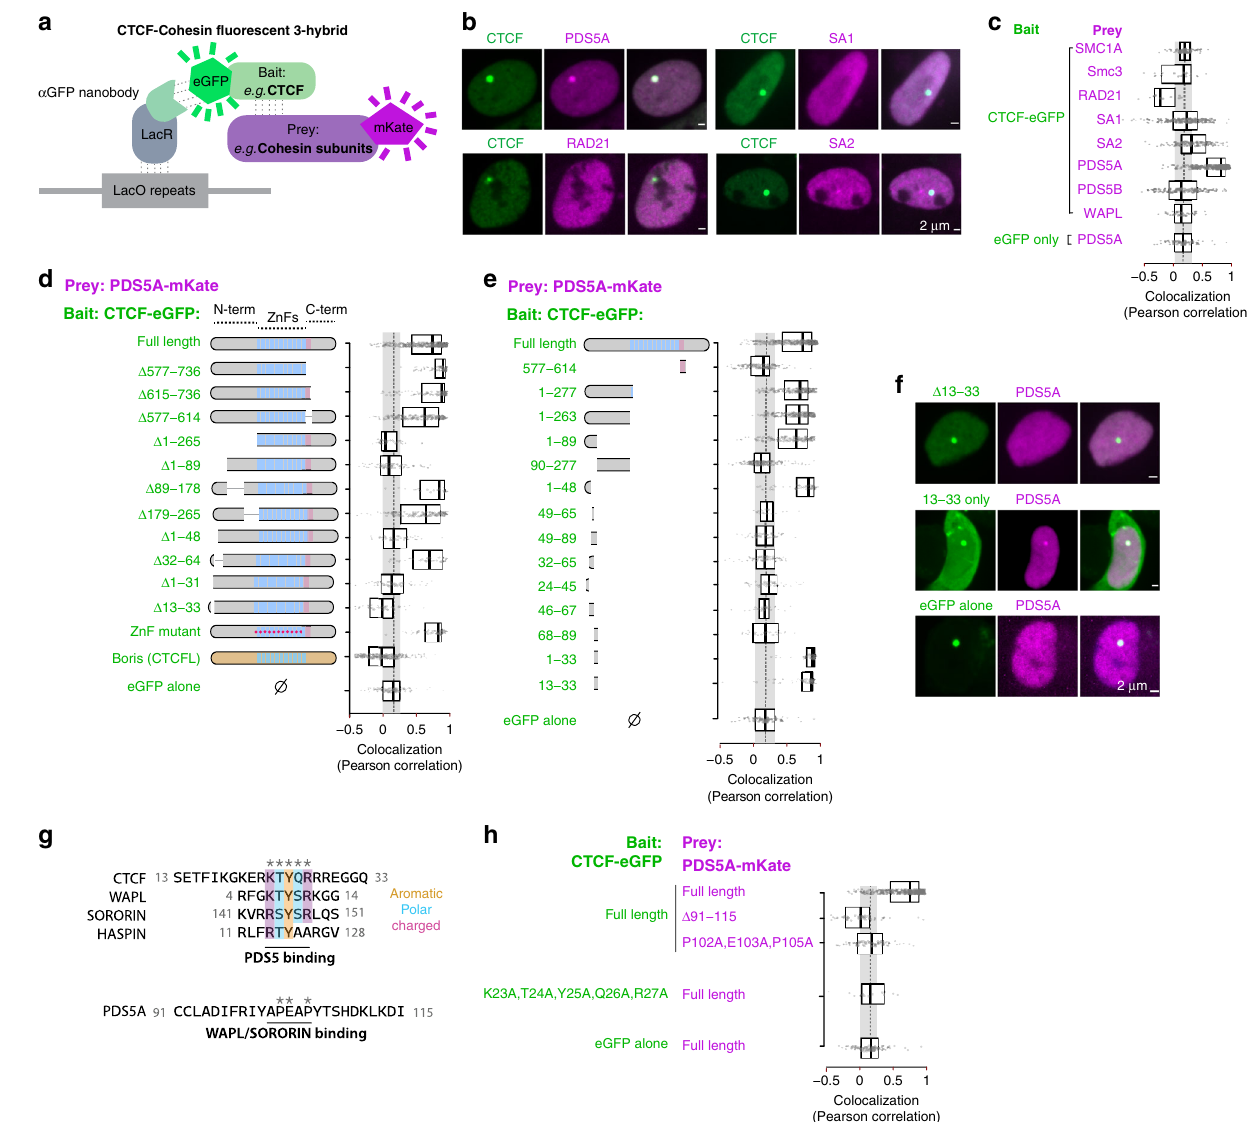
Fig. 4 The CTCF N terminus can interact with the PDS5A cohesin subunit via a motif shared with WAPL and SORORIN. a Fluorescent three-hybrid setup testing the ability of CTCF to recruit cohesin subunits in BHK-LacO cells. b , c PDS5A is the only subunit recruited by CTCF by F3H. Each data point corresponds to the Pearson correlation between the green (CTCF) and red (cohesin subunits) channels at one GFP-positive LacO array. High values denote high colocalization of CTCF and cohesin subunits at the array. Boxplots indicate the fi rst and third quartile and median. d Deleting CTCF N(13 – 33) prevents PDS5A recruitment in F3H. e , f N(13 – 33)-eGFP is suf fi cient to recruit PDS5A by F3H. g CTCF N(23 – 27) aligns with the known PDS5-binding region of WAPL, SORORIN, and HASPIN reported to interact with the APEAP motif of PDS5. h Mutation of the APEAP motif of PDS5A prevents its recruitment